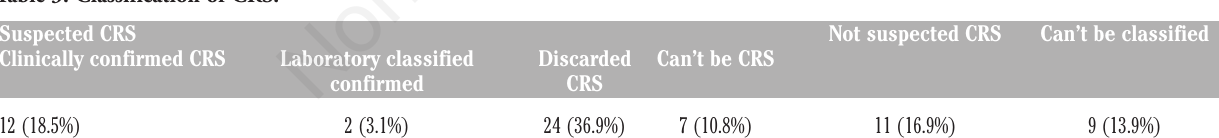
Table 3. Classification of CRS.